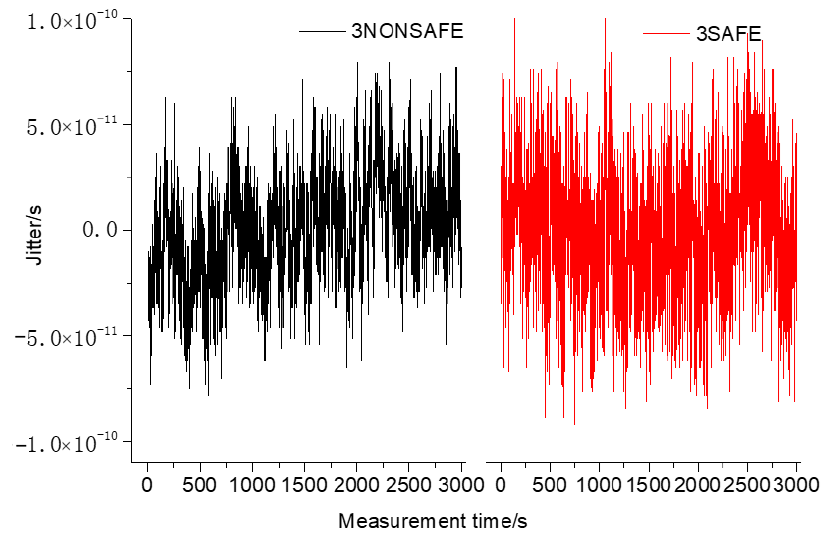
Figure 9. Comparison of jitter using three safe and non-safe equipment.